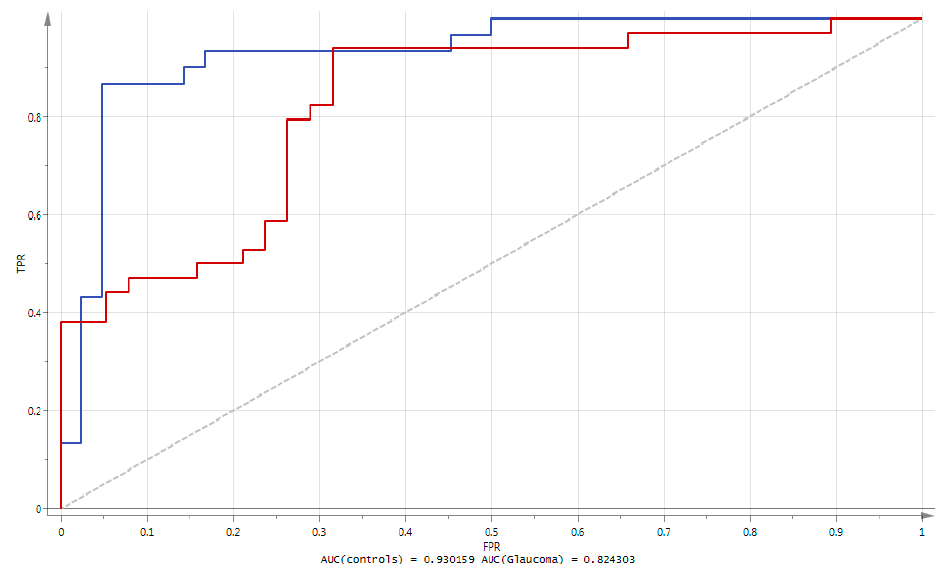
Figure 2. Results of the Receiver Operating Characteristic (ROC) curve analysis using the 8 metabolites derived from the multivariate OPLS-DA model. The blue line represents the Area Under the ROC Curve (AUC) obtained for controls, whilst the red line represents the AUC obtained for glaucoma patients. The ROC plots represent the sensitivity (i.e., True Positive Rate TPR) versus 1—the specificity (i.e., False Positive Rate